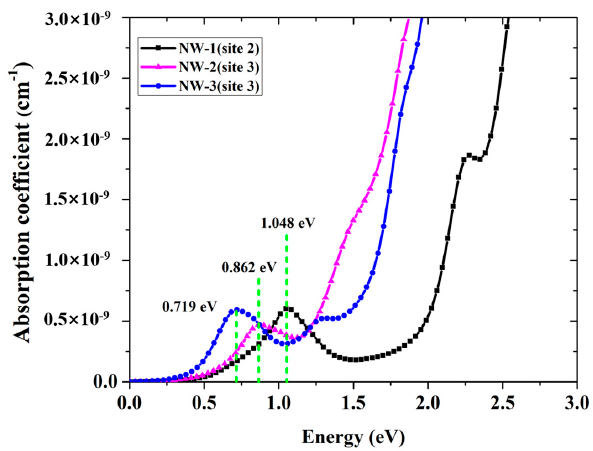
Figure 6. Absorption spectrum of Cr 2+ :ZnSe NWs of different sizes.